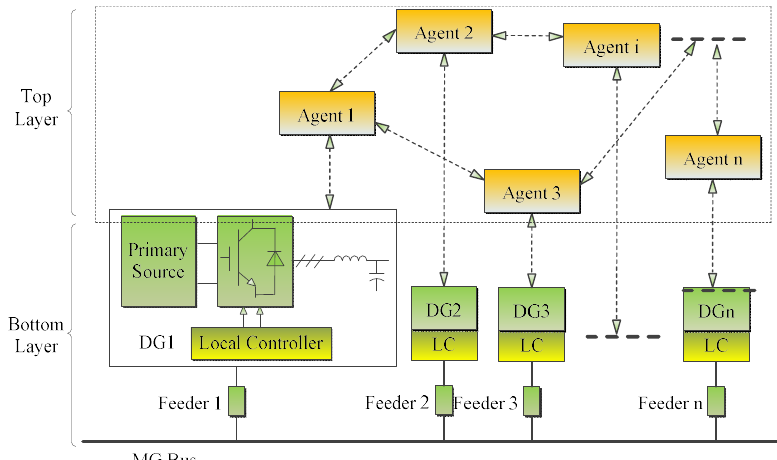
Figure 1 . MAS-based islanded MG model. Figure 1. MAS-based islanded MG